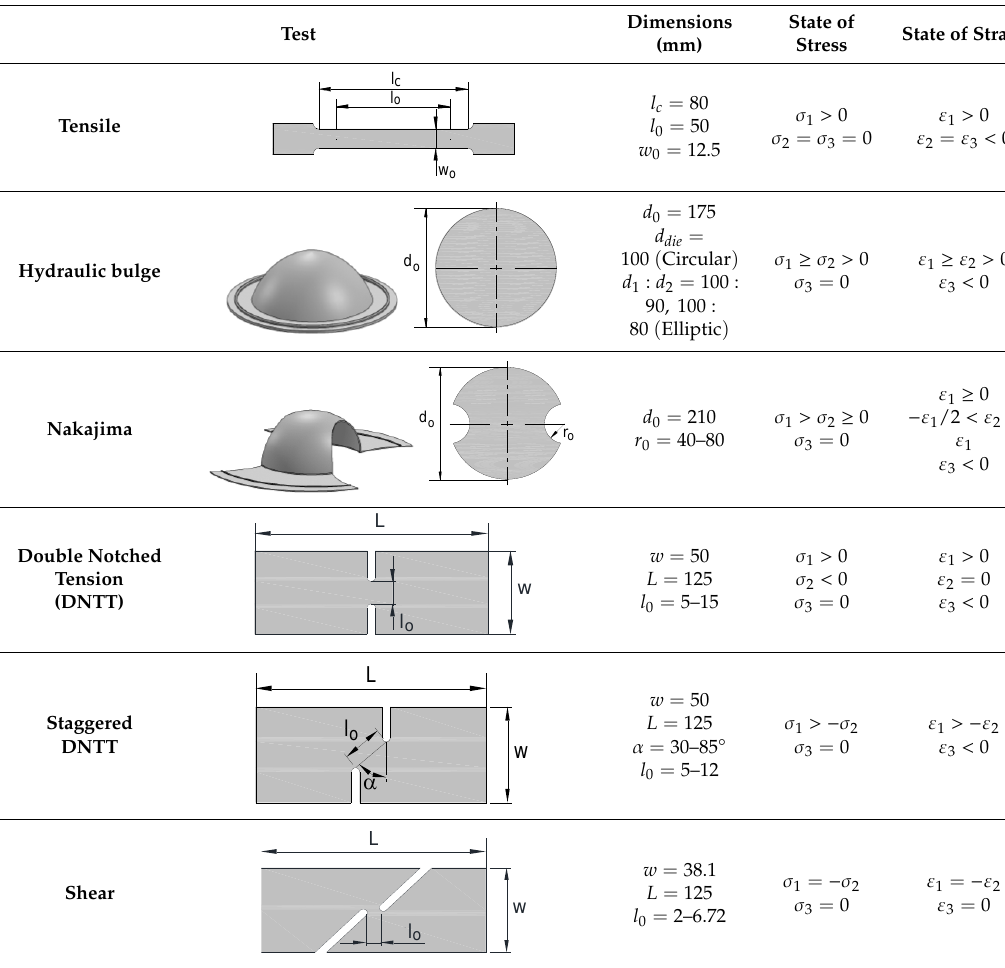
Table 4. Schematic representation of the experimental sheet formability tests performed in the aluminium AA1050-H111 and copper sheets.